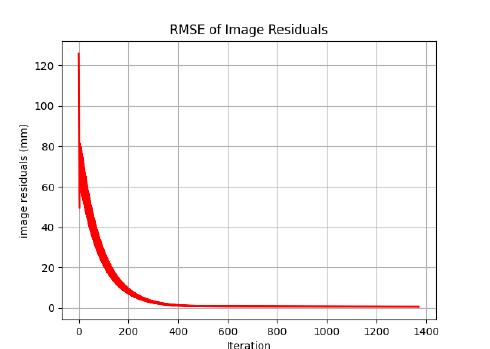
Figure 5. Displaying RMSE of image residuals in Bundle adjustment loop.